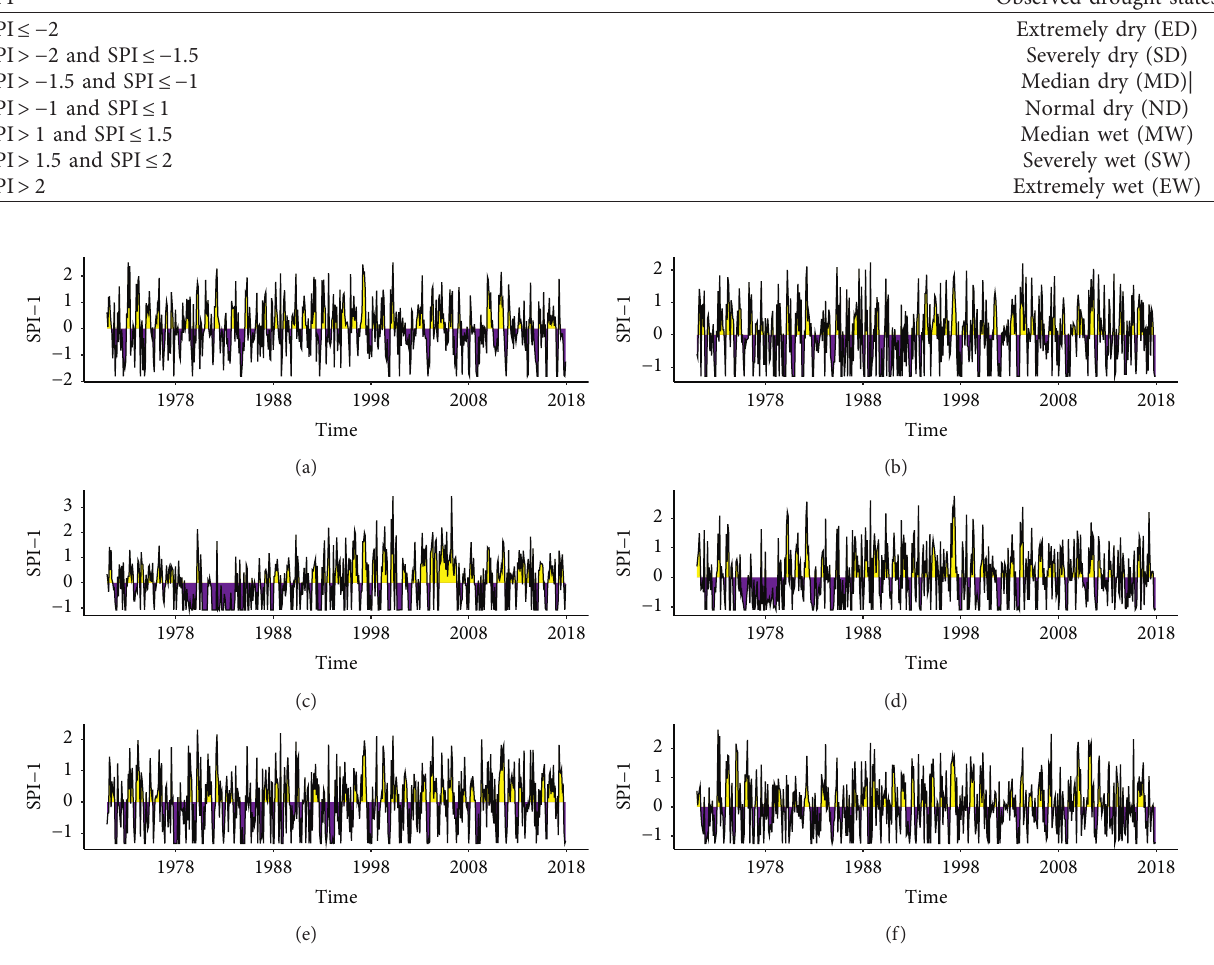
Figure 3: The temporal presentation of SPI at scale-1 for varying stations. (a) Astore, (b) Bunji, (c) Gupis, (d) Chilas, (e) Gilgit, and (f) Skardu. Table 3: The behavior of various drought classes for SPI at scale-1 in selected